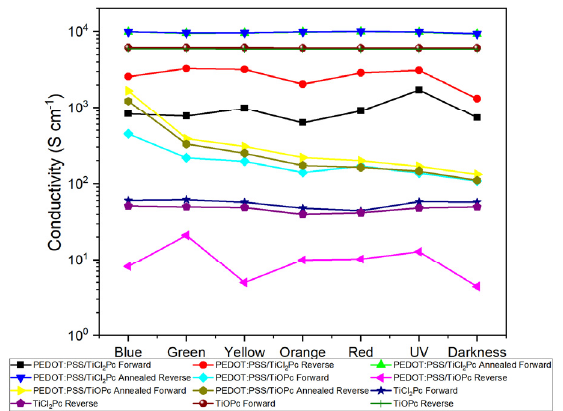
Figure 13. Forward and reverse bias device conductivity.